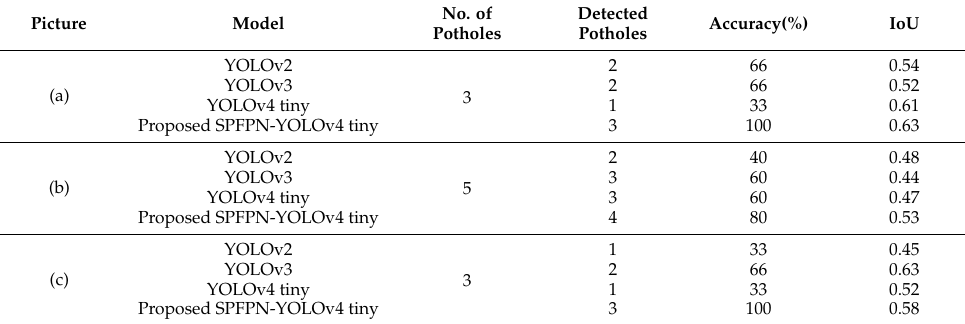
Figure 11. Detection result sample on the test dataset. Table 7. IoU comparison according to each YOLO